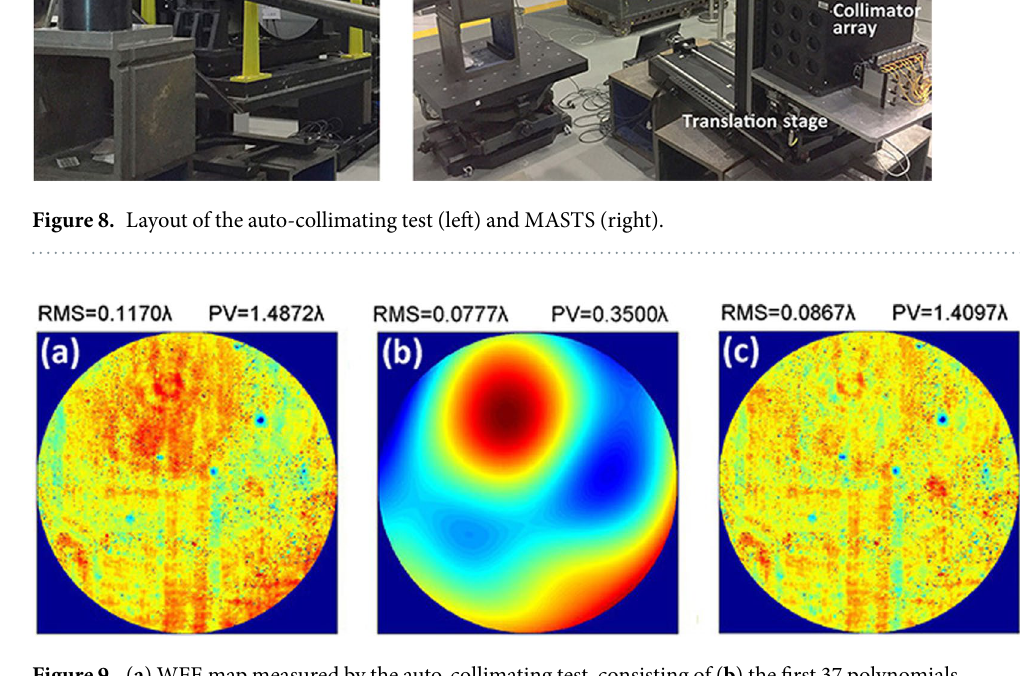
Figure 9. ( a ) WFE map measured by the auto-collimating test, consisting of ( b ) the first 37 polynomials Zernike fit and ( c ) the residual